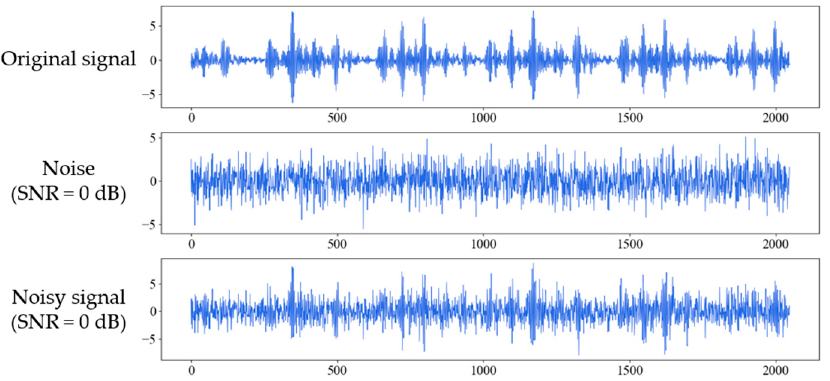
Figure 5. Figures for original signal of inner race fault (IRF-0.021), the additive white Gaussian noise, and the composite noisy signal with SNR = 0 dB respectively.